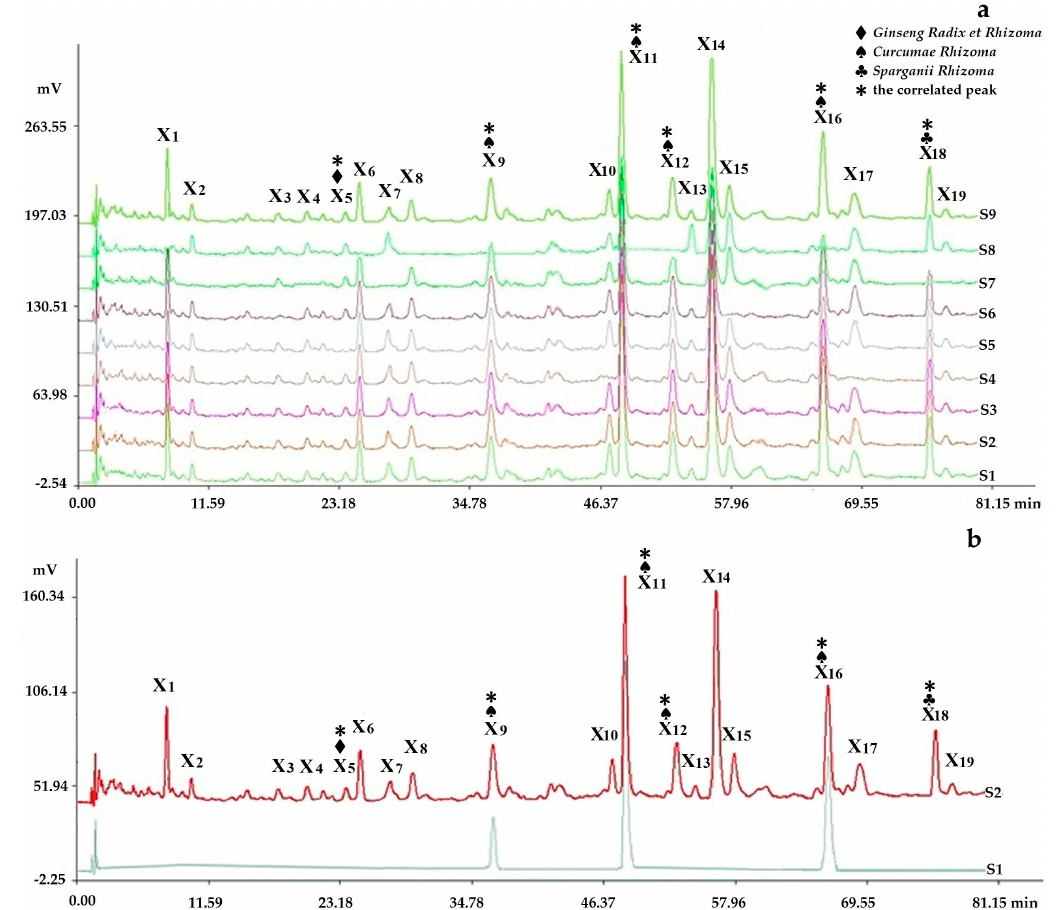
Figure 6. Chromatogram comparing the fingerprints analyzed by chromatographic condition I (HPLC-PDA) with negative control samples and reference standard samples: ( a ) S1–S8 were respectively the negative sample without Hirudo , without Epimedii Folium , without Cervi Cornu Pantotrichum , without Fritillariae Thunbergii Bulbus , without Ginseng Radix et Rhizoma , without Astragali Radix , without Sparganii Rhizoma , and without Curcumae Rhizoma , in which peak 5 was from Ginseng Radix et Rhizoma ; peaks 9, 11, 12, and 16 were from Curcumae Rhizoma ; peak 18 was from Sparganii Rhizoma by comparing with the negative control solutions (S1–S8); ( b ) S2 and S1 were respectively the fingerprints of the sample solution and reference standard solution, in which three peaks were respectively identified by comparing with the reference standard substance: peak 9, germacrone; peak 11(S), furandiene (reference peak); peak 16, β -elemene.